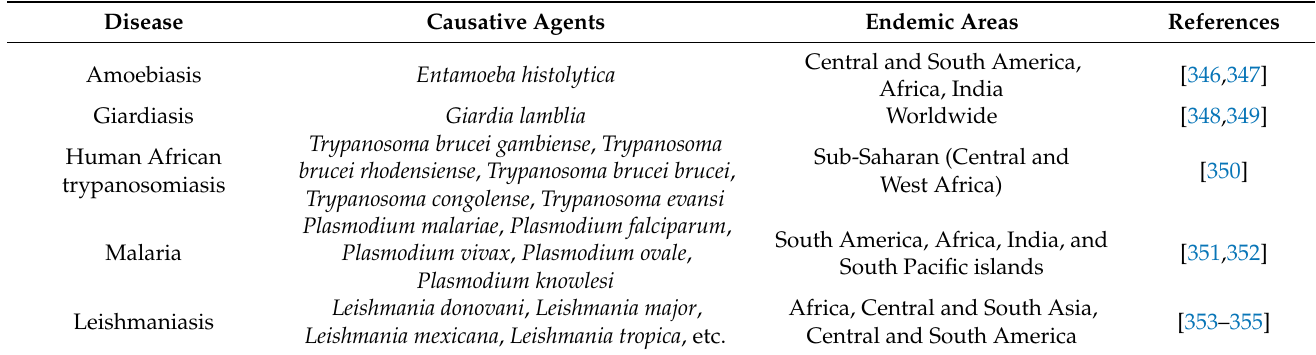
Table 5. Protozoal diseases discussed in the text and their causative agents.